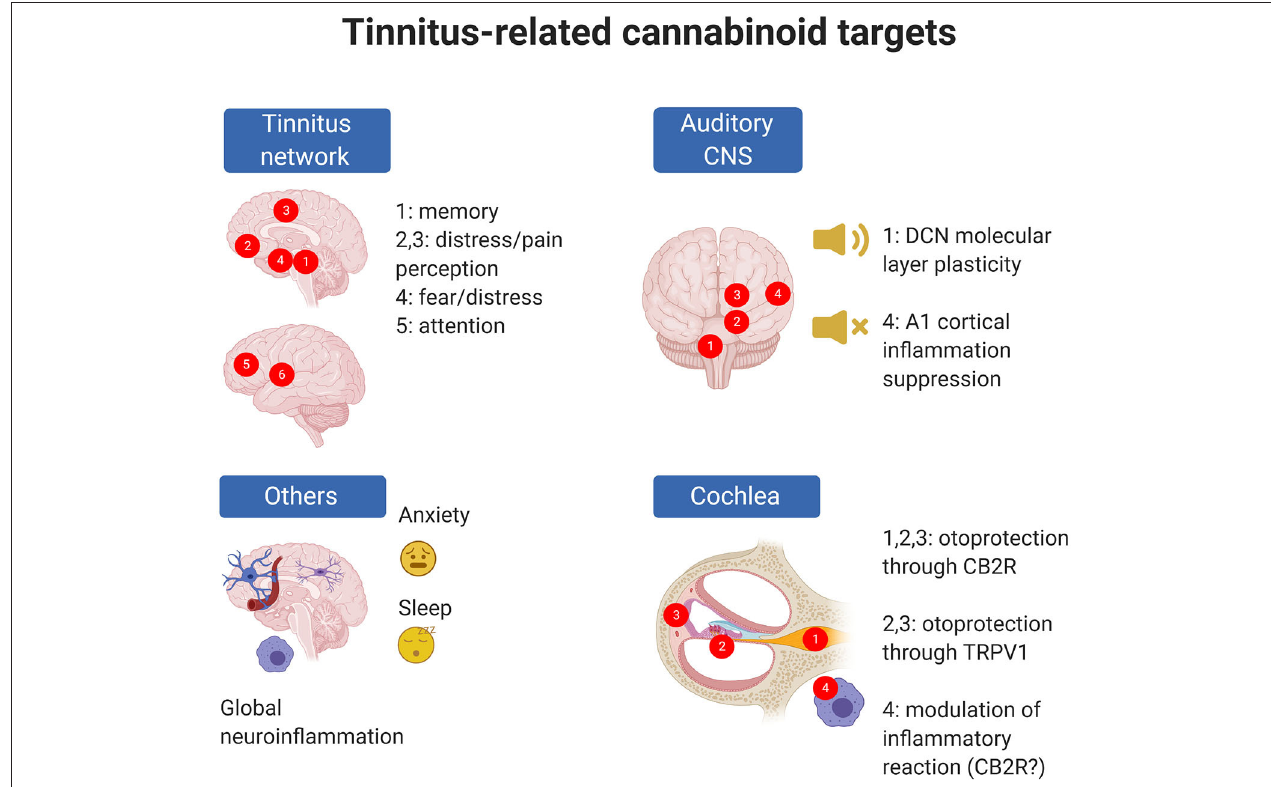
FIGURE 2 | Tinnitus-related EC targets are present in the cochlea and central auditory system but also in CNS circuits altered in tinnitus; moreover, ECs may target phenomena which are known to be associated with tinnitus risk (e.g., anxiety) even though precise cellular mechanisms are uncertain. In panel “Tinnitus network,” numbers indicate as follows: 1: parahippocampal cortex; 2: ventromedial prefrontal cortex; 3: cingulate cortex; 4: amygdala; 5: dorsolateral prefrontal cortex; 6: insula (from 273). In panel “Auditory CNS” numbers indicate as follow: 1: cochlear nuclei; 2: auditory pons and midbrain; 3: medial geniculate body; 4: auditory cortex. In panel “Cochlea,” numbers indicate as follows: 1: spiral ganglion; 2: organ of Corti; 3: stria vascularis; 4: cochlear macrophages. Created with